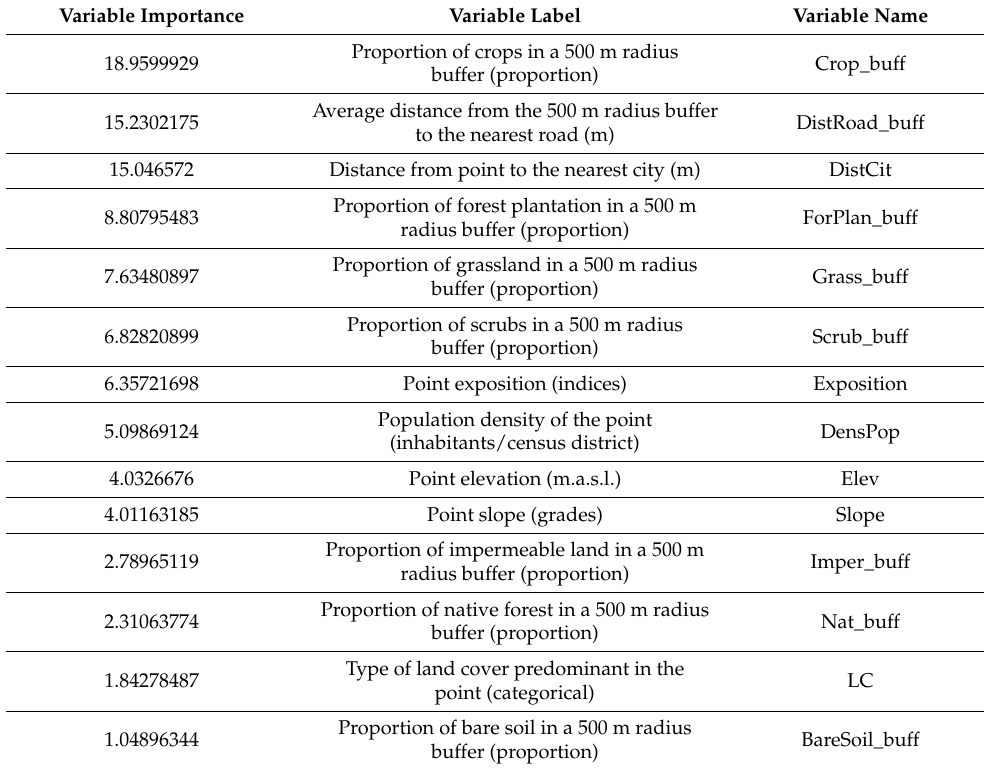
Figure 5. Confusion matrix.